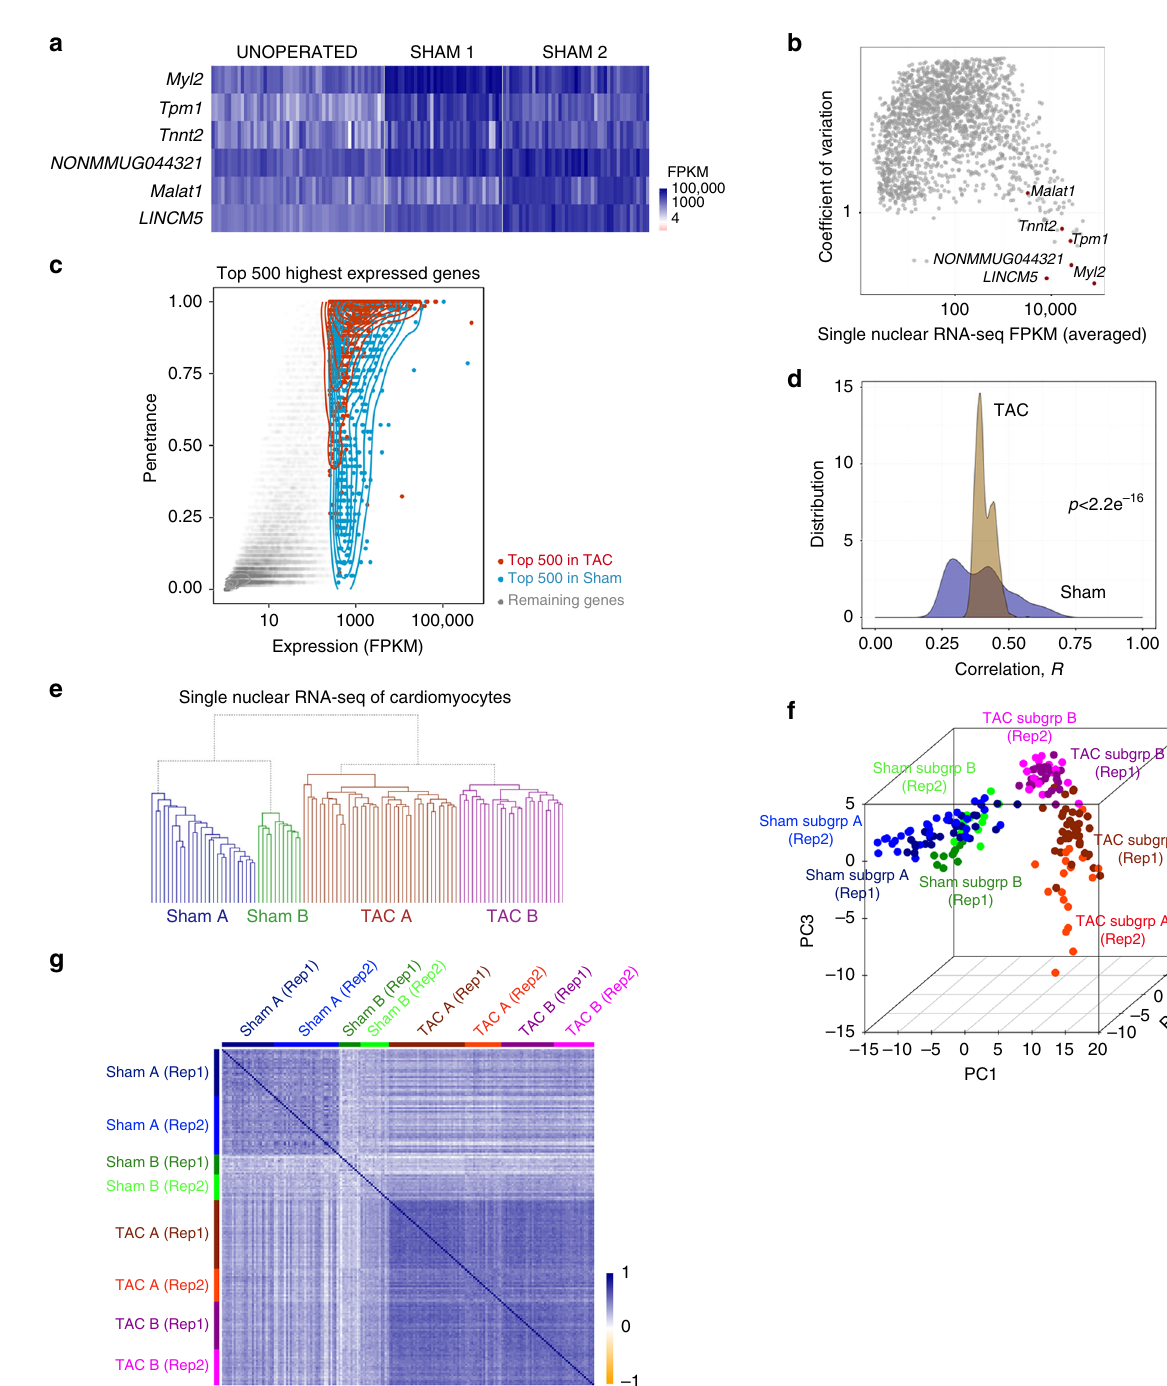
Fig. 1 Single nuclear RNA-seq reveals CM heterogeneity. a , b Core cardiac genes that are most highly expressed in every CM nucleus ( a ) exhibit high expression with low coef fi cient of variation ( b ). c Highly expressed genes in TAC nuclei have higher penetrance than highly expressed genes in Sham nuclei. Spearman ’ s rank correlation ( r = 0.90, p < 2.2e − 16 ) shows good correlation between average expression level and penetrance. d Density distribution of correlation shows higher correlation in TAC nuclei than in Sham nuclei. p < 2.2e − 16 from Mann – Whitney U test. e , f Unsupervised hierarchical clustering e and PCA f of single nuclear RNA-seq of CM reveal that CM nuclei accurately segregate into clusters speci fi c to Sham or TAC subgroups (subgroup a , b ) and is replicated across biological repeats (Rep) f . g Ranked Spearman correlation plot shows higher correlation in TAC nuclei than in Sham nuclei, which is replicated across biological repeats